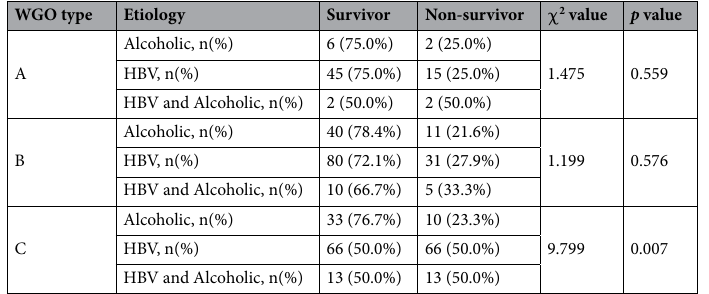
Table 1. Prognostic impact of HBV infection and alcoholic liver disease as basic etiologies in patients with ACLF, stratified by WGO types A, B, and C. HBV Hepatitis B